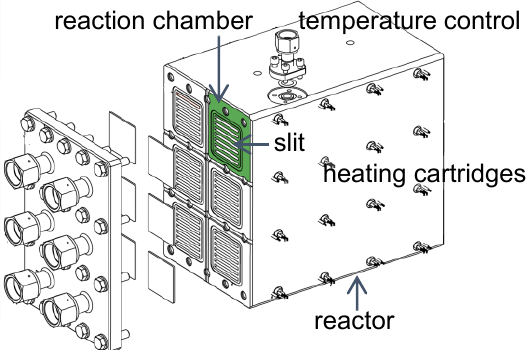
Figure 1. Pilot plant SEWGS reactor with six individually fed reaction chambers. Every chamber consists of seven slits. Isothermal conditions are ensured with adjacent channels between the slits for tempering with purge